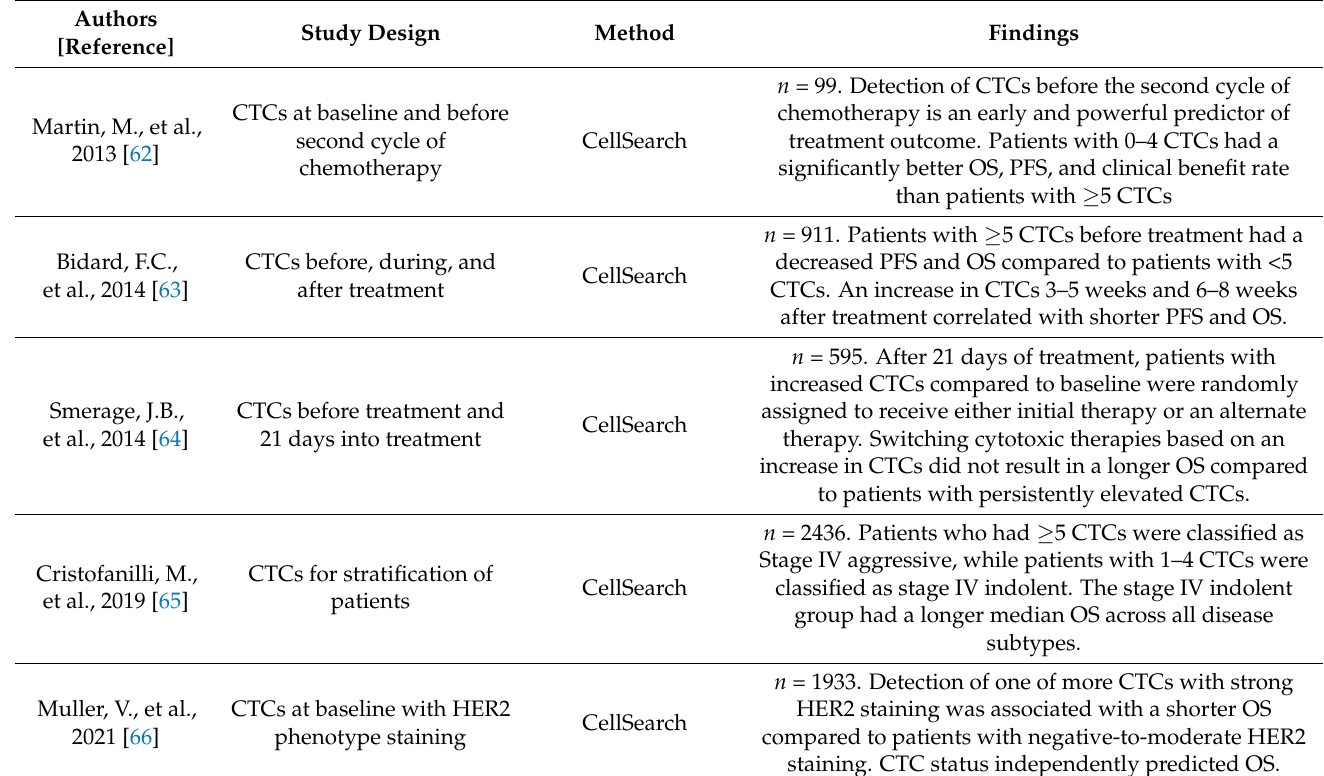
Table 3. CTCs in metastatic breast